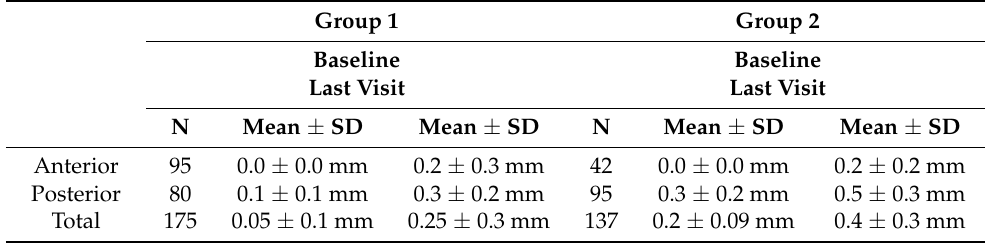
Table 5. PI change for different groups (Group 1: EA > 30 ◦ ; Group 2: EA ≤ 30 ◦ ). N: number of implants; SD: Standard